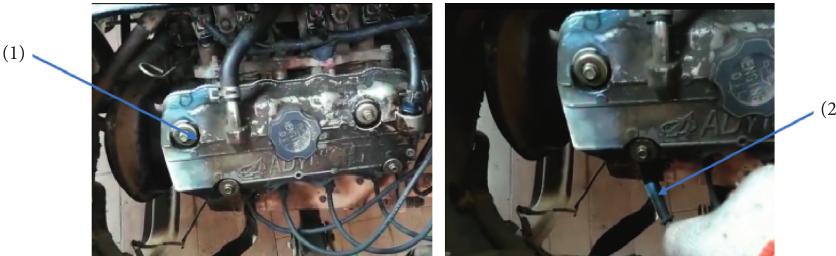
Figure 13: Fault components extracted accurately. W D opt W 110 , and